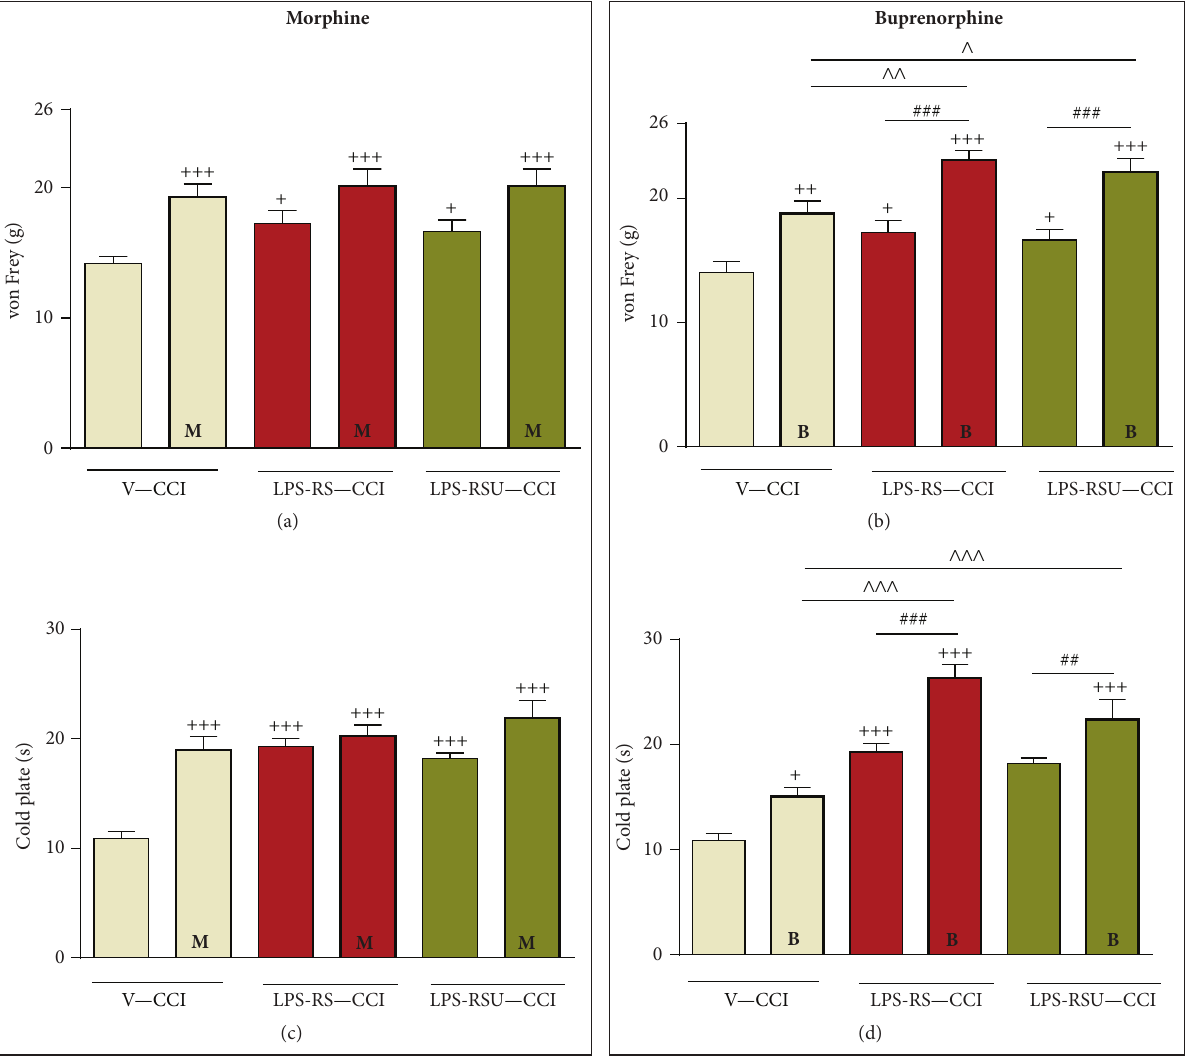
Figure 6: The influence of a single intrathecal administration of vehicle (“V”, sterile water), LPS-RS [20 𝜇 g/5 𝜇 L], or LPS-RS Ultrapure [“LPS- RSU” 20 𝜇 g/5 𝜇 L] on morphine (“M”, 2.5 𝜇 g/5 𝜇 L; (a), (c)) or buprenorphine (“B”, 2.5 𝜇 g/5 𝜇 L; (b), (d)) analgesia, as measured by von Frey’s test (mechanical allodynia; (a), (b)) and the cold plate test (thermal hyperalgesia; (c), (d)) 7 days after chronic constriction injury (CCI). The data are presented as the mean ± SEM. Intergroup differences were analyzed using one-way ANOVA followed by Bonferroni’s multiple comparisons test. + 𝑝 < 0.05 , ++ 𝑝 < 0.01 , and +++ 𝑝 < 0.001 indicate significant differences compared with the vehicle-treated, CCI-exposed rats (V-CCI); # 𝑝 < 0.05 , ## 𝑝 < 0.01 , and ### 𝑝 < 0.001 indicate significant differences between the LPS-RS and LPS-RS Ultrapure treated CCI- exposed groups after additional vehicle administration comparing to additional morphine or buprenorphine treated CCI-exposed groups; ∧ 𝑝 < 0.05 , ∧∧ 𝑝 < 0.01 , and ∧∧∧ 𝑝 < 0.001 indicate significant differences between vehicle-treated CCI-exposed groups after morphine or buprenorphine treatment and LPS-RS/LPS-RSU opioid treated CCI-exposed